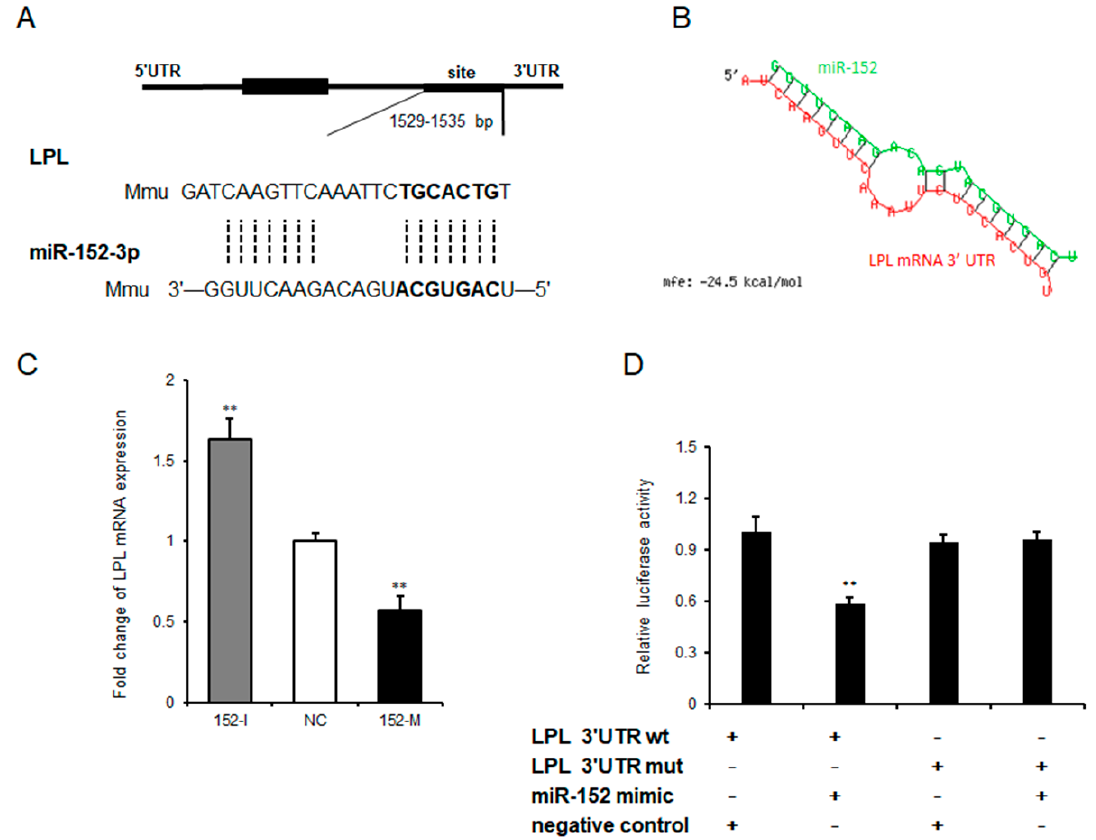
Figure 4. Lipoprotein lipase is a target of miR-152. ( A ) The sequence alignment of miR-152 with 3 ′ -UTR of mouse lipoprotein lipase (LPL) mRNA. The binding site and seed region of miR-152 re indicated in bold. ( B ) The minimum free energy of miR-152 and LPL mRNA was predicted using RNAhybrid. ( C ) The mRNA expression level of LPL was detected by qRT-PCR after 3T3-L1 cells transfected with the miR-152 mimic, the miR-152 inhibitor or the negative control on day eight. ( D ) The repressive effect of miR-152 on the activity of LPL 3 ′ UTR was measured by a dual-luciferase assay. Results are presented as means ± SD. n = 3. * p < 0.05; ** p < 0.01.